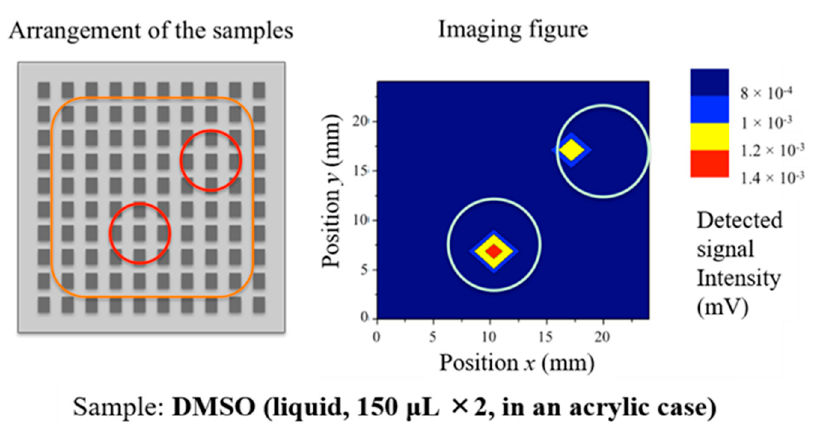
Figure 17. Two-dimensional imaging of dielectric samples (DMSO).